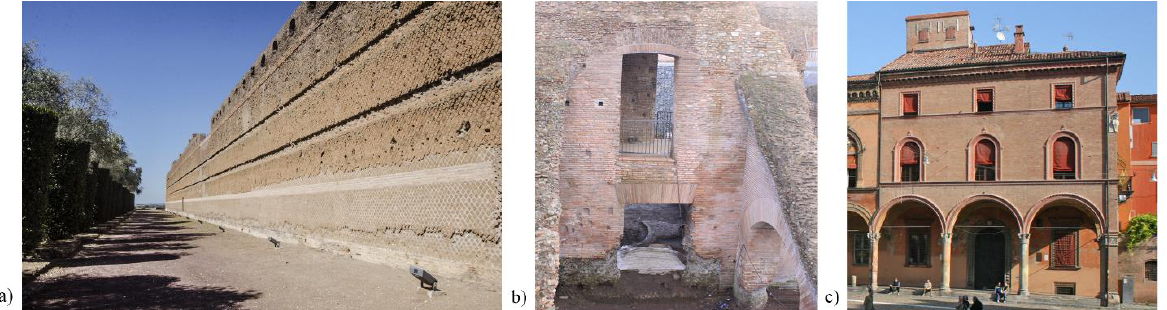
Figure 3: The case studies of the work to validate the semantic classification for analyses and restoration purposes: Pecile’s wall of Villa Adriana in Tivoli, Italy (a), Cavea walls of the Circus Maximus in Rome, Italy (b) and portico in Bologna, Italy (c).